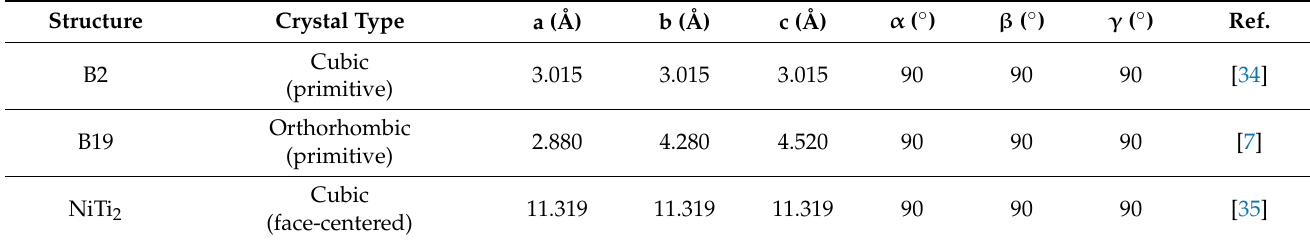
Table 4. Summary of the crystal type and the lattice parameters of the identified crystal structures. Structure